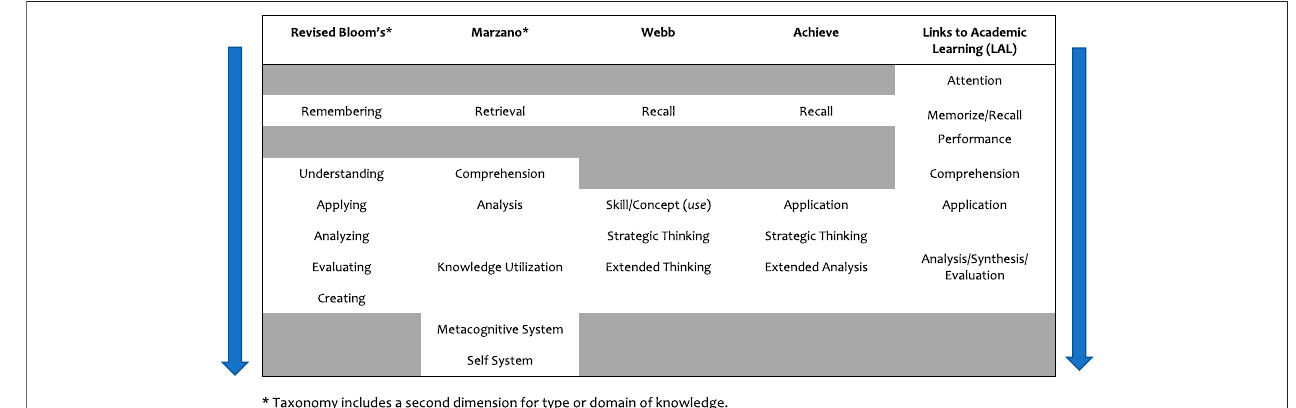
FIGURE 1 | Summary of common cognitive processing classi fi cations from lowest to highest complexity